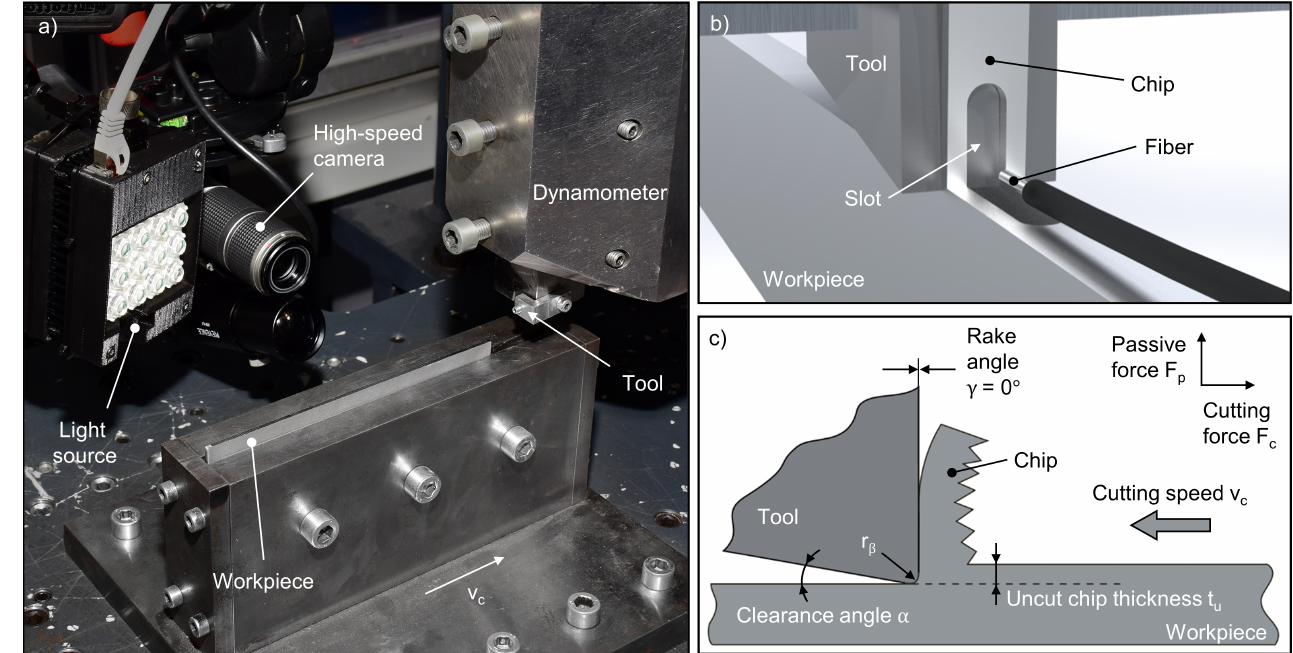
Figure 1. Orthogonal cutting tests. ( a ) Experimental setup with measurement devices; ( b ) Principle of rake face temperature measurement; ( c ) Schematic illustration of the orthogonal cutting